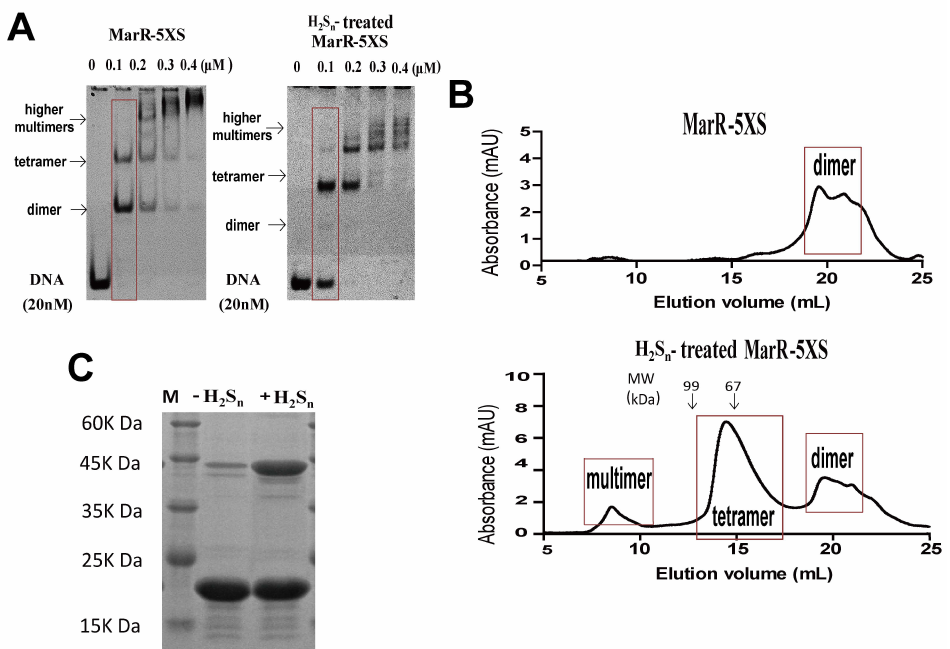
Figure 2. MarR sensed sulfane sulfur via Cys80. ( A ) EMSA analysis of H 2 S n -treated and untreated MarR-5XS in the presence of its DNA probe (20 nM). ( B ) Size-exclusion chromatography revealed the formation of disulfide-stabilized tetramer of MarR-5XS (25 µ M) after 400 µ M H 2 S n treatment for 20 min. The molecular weight (MW) of tetramers was calibrated with BSA (67 kDa) and T7 RNA polymerase (99 kDa). ( C ) Non-reducing SDS-PAGE analysis of MarR-5XS (25 µ M). The protein was treated with H 2 S n (400 µ M) for 20 min, terminated by adding 500 µ M iodoacetamide before analysis.